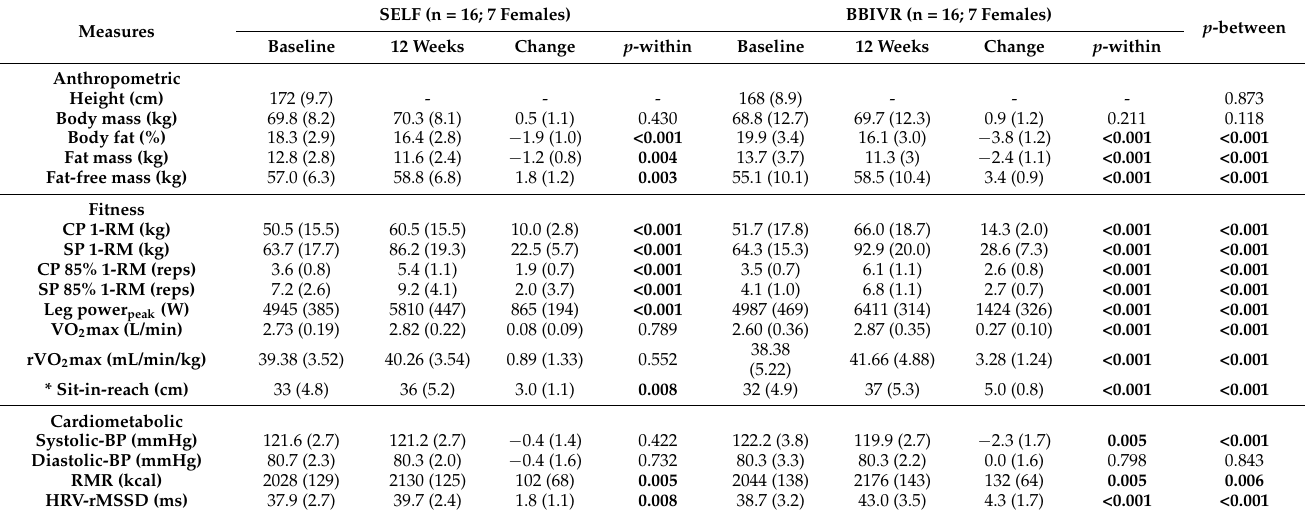
Table 1. Anthropometric, fitness, and cardiometabolic measures at baseline and after 12 weeks for the IVR and SELF